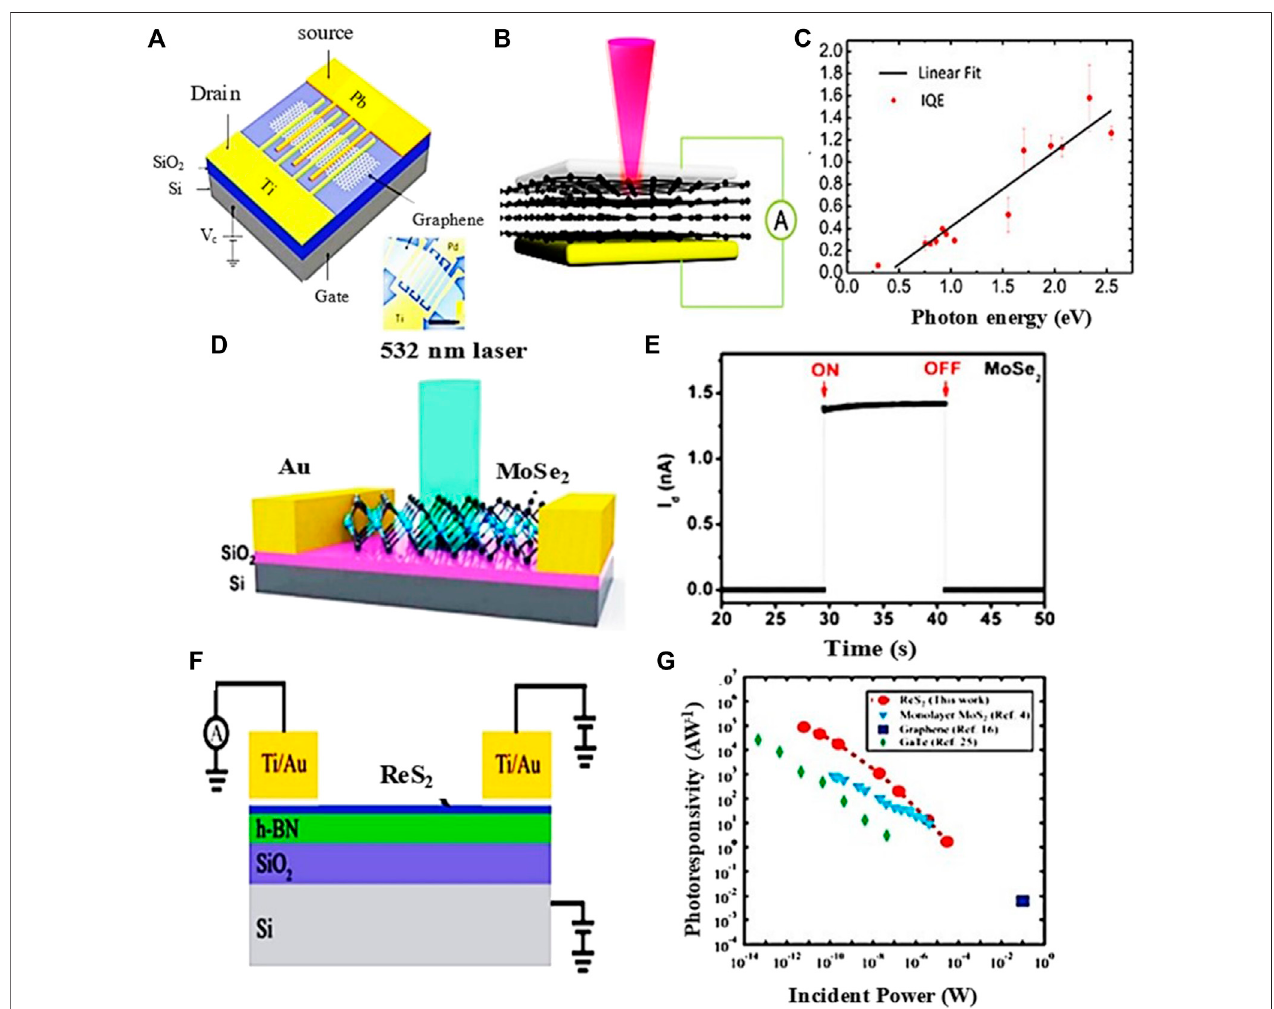
FIGURE 15 | (A) Graphene photodetector with different metal contacts (Mueller et al., 2010), (B) Schematic of graphene stacked device (Chen et al., 2015), (C) Graphene stacked based photon energy dependence on IQE, (D) Monolayered MoSe 2 photodetector (Wang et al., 2018), (E) With its time resolved current (Wang et al., 2018), (F) Multilayered RSe 2 photodetector (Liu et al., 2016b), and (G) With its responsivity (Liu et al., 2016b); Reproduced with permission from (Mueller et al., 2010; Liu et al., 2016b; Chen et al., 2015; Wang et al., 2018).